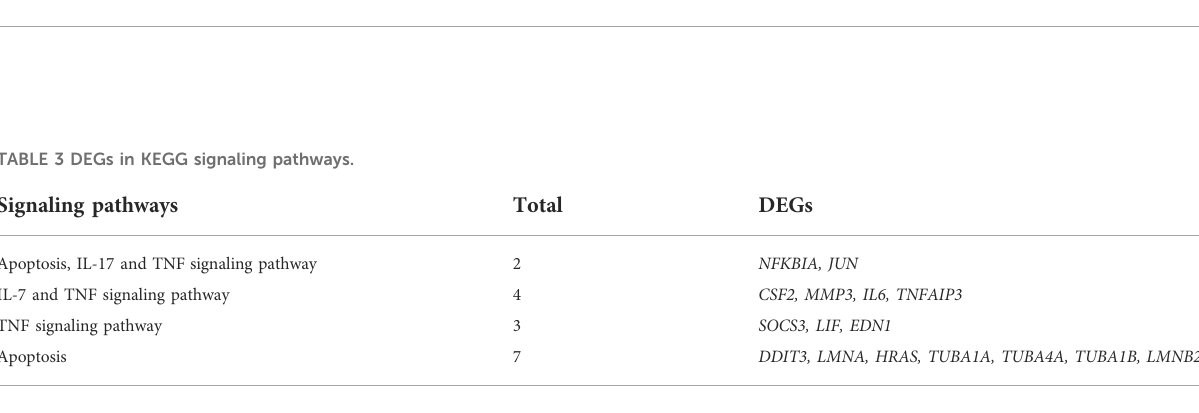
FIGURE 5 Analysis results fromtranscriptionstudy inOGD/R-exposedHUVECstreated withHGG. (A) The volcano graph of227DEGsbetweenincubated HGG+OGD/RgroupandOGD/Rgroup.Red,upregulatedDEGs;green,downregulatedDEGs; (B) Heatmaprepresentation; (C) Thevenndiagramof DEGs in KEGG signaling pathway; (D) GO enrichment and (E) KEGG pathway analysis of 227 DEGs in HGG treated HUVECs after OGD/R.